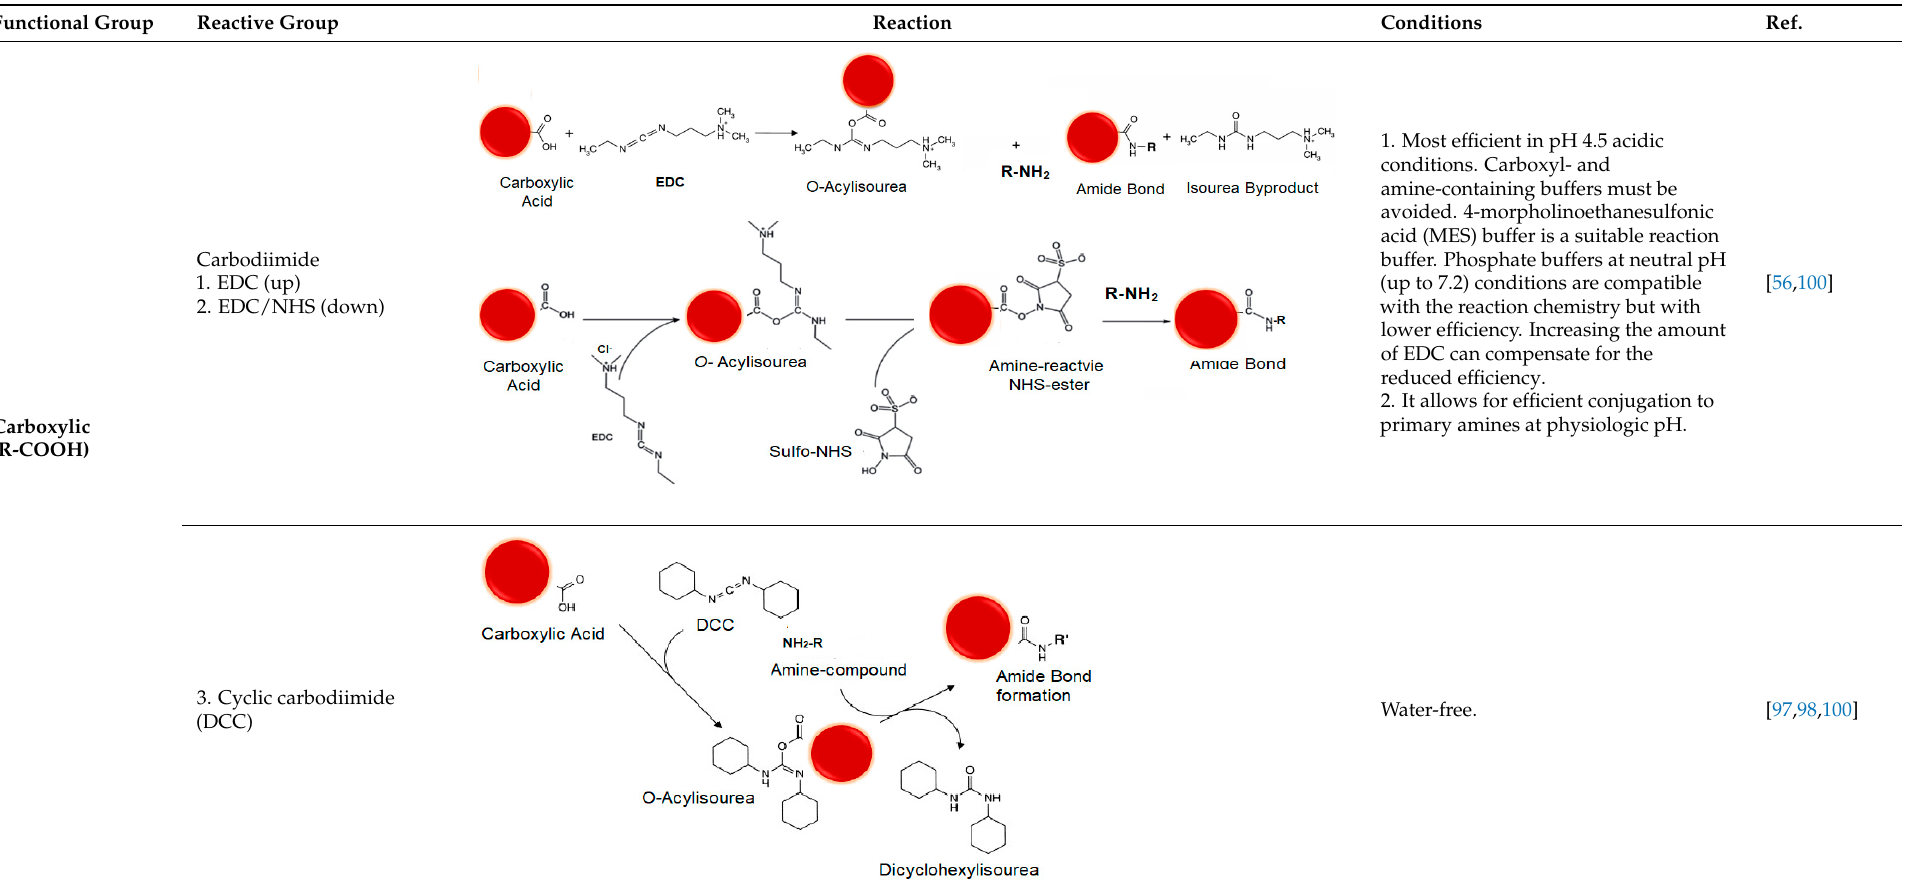
Table 2. Summary of surface chemistries to functionalize NPs.